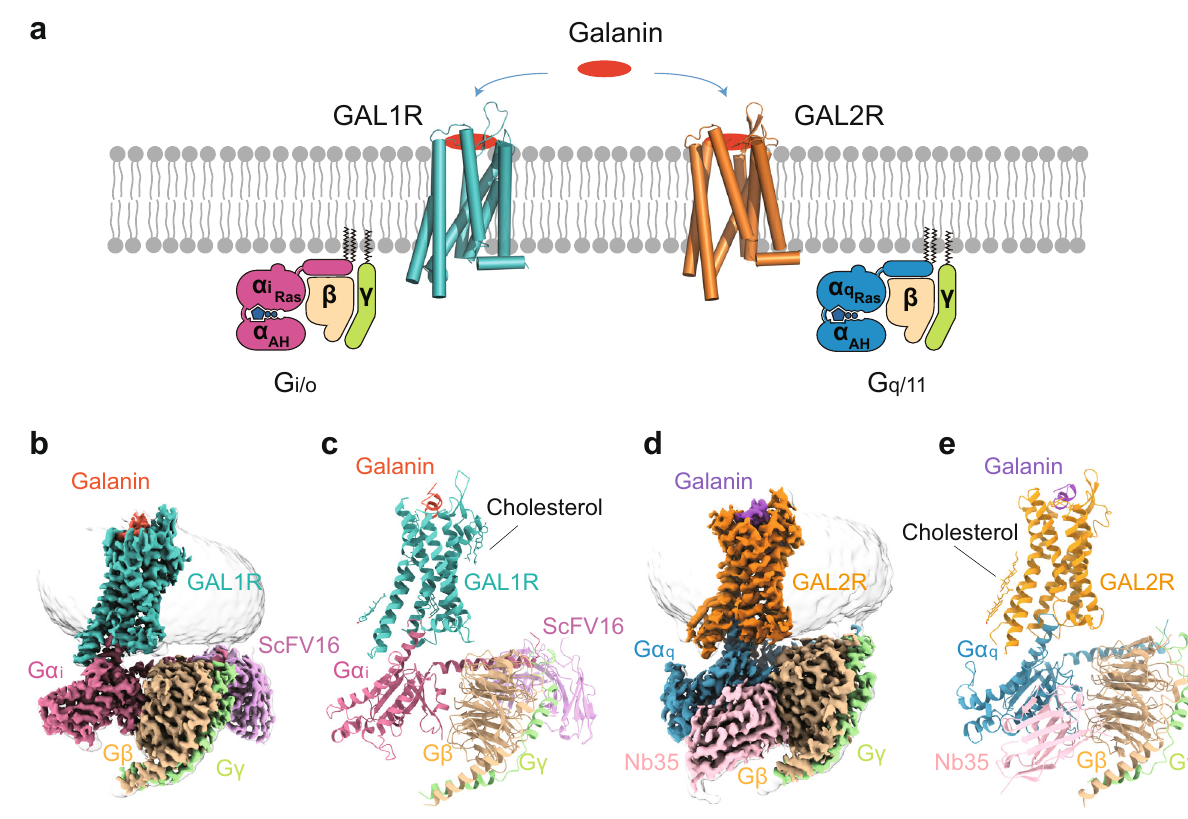
Fig. 1 Cryo-EM structures of galanin-GAL1R-G i and galanin-GAL2R-G q complexes. a Schematic illustration of G protein coupling of galanin receptors activated by galanin. Three-dimensional map ( b ) and the model ( c ) of the galanin-GAL1R-G i complex. Three-dimensional map ( d ) and the model ( e ) of the galanin-GAL2R-G q